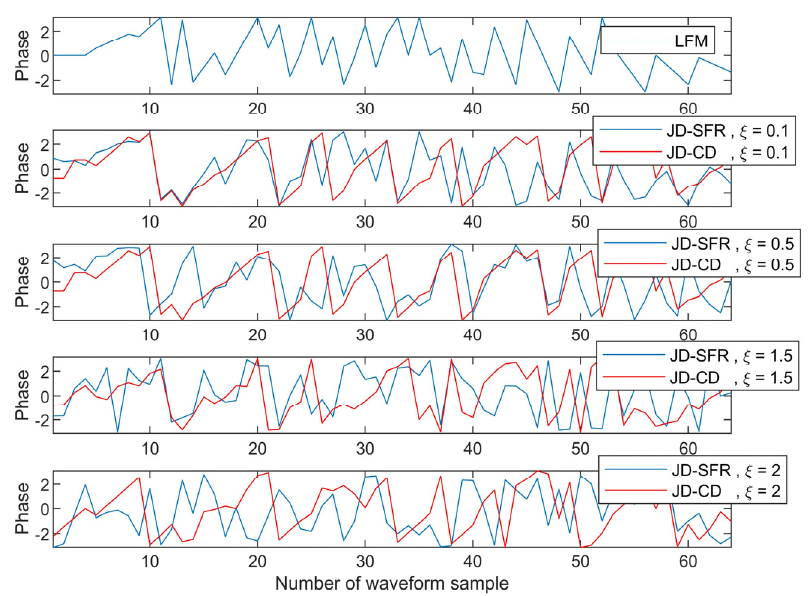
Figure 10. The phase difference between designed waveform and LFM under different similarity coefficients.